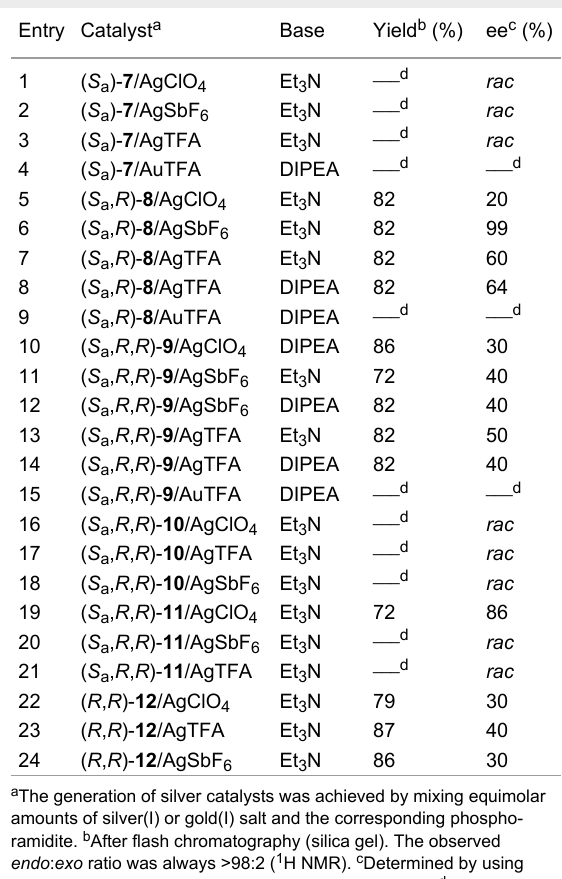
Table 1: Optimization of the 1,3-dipolar cycloaddition of 6b and tert- butyl acrylate using chiral phosphoramidite